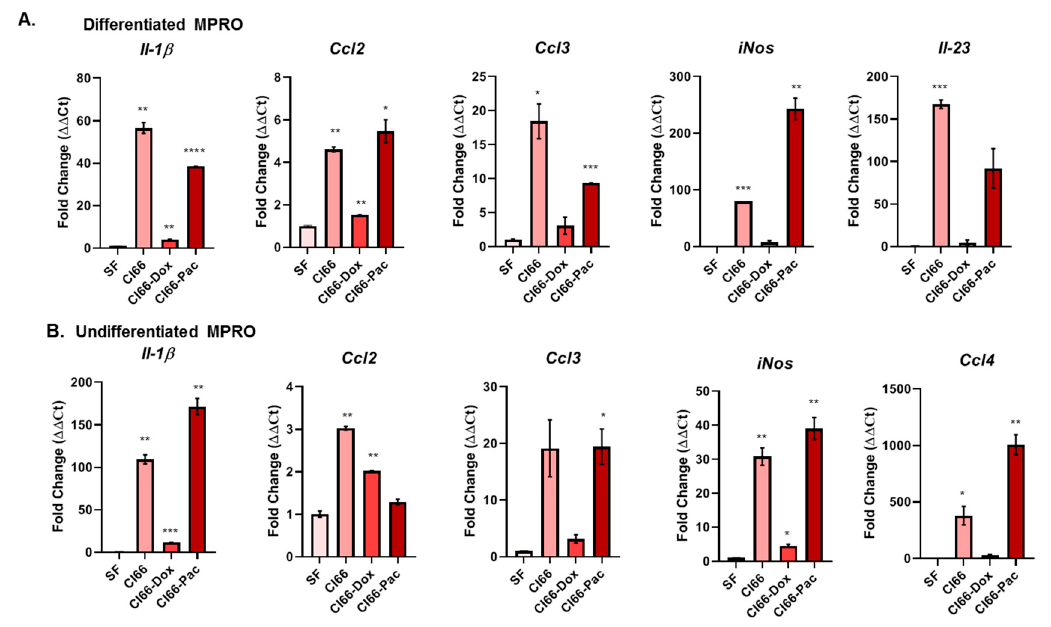
Figure 4. Breast cancer cells modulated the expression of neutrophil-secreted pro-tumor factors. ( A ) Bar graph showing fold changes in interleukin-1 β ( Il-1 β ), CC-chemokine ligand-2-4 ( Ccl2 , Ccl3 , Ccl4 ), Interleukin-23 (Il23) and inducible nitric oxide synthase ( iNos ) expression in di ff erentiated MPRO cells cultured in the supernatant of SF media, Cl66, Cl66-Dox, and Cl66-Pac cells using quantitative RT-PCR. The relative expression of Gapdh was used for normalization. MPRO cells cultured in the supernatant of SF media was treated as the control. ( B ) Bar graph showing fold changes in or the expression of Il-1 β , Ccl2 , Ccl3 , Ccl4 , and iNos in undi ff erentiated MPRO cells cultured in the supernatant of SF media, Cl66, Cl66-Dox, and Cl66-Pac cells using quantitative RT-PCR. The relative expression of Gapdh was used for normalization. MPRO cells cultured in the supernatant of SF media was treated as the control. The values are mean fold change ± SEM; and unpaired t-test with the assumption that both populations had the same SD; * p < 0.05; ** p < 0.01; *** p ≤ 0.001; **** p ≤ 0.0001. The data are representative of three independent experiments performed in duplicate with similar results.